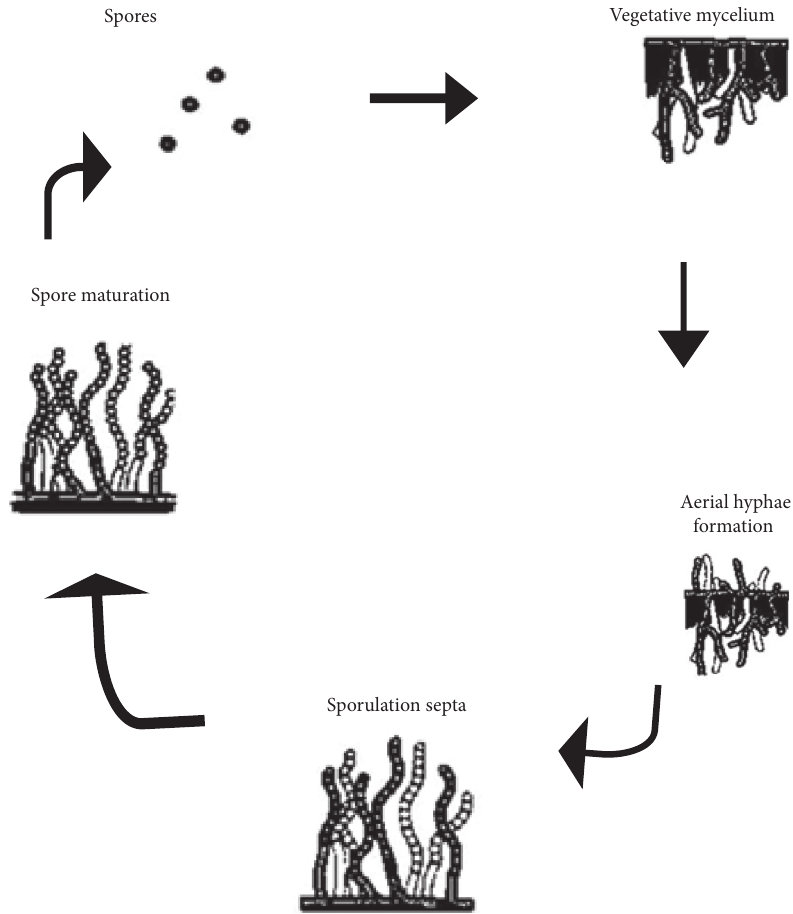
Figure 2: Life cycle of streptomycetes